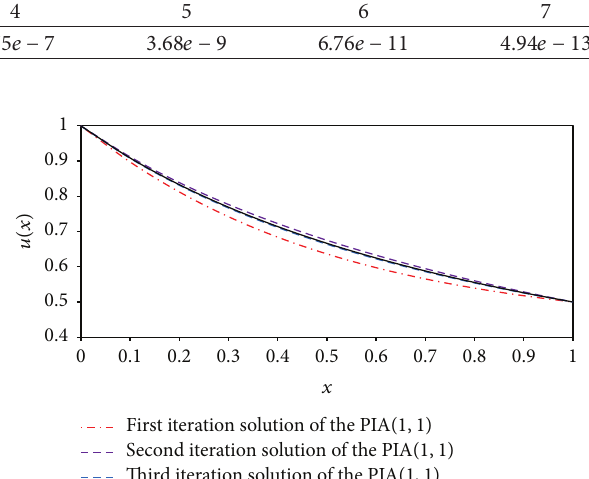
Table 5: The absolute maximum errors 𝐸 𝑛 for example 5 .